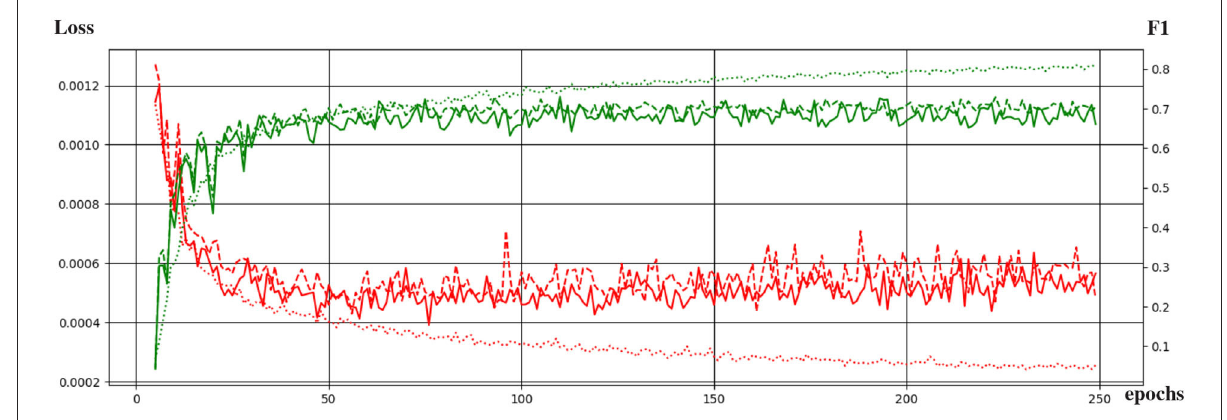
FIGURE4 Evolution of the training of the neural network with the training epochs. The loss function and the F1 score are shown in red and green, respectively. Dotted, continuous, and dashed lines correspond to performance during training, validation, and testing.